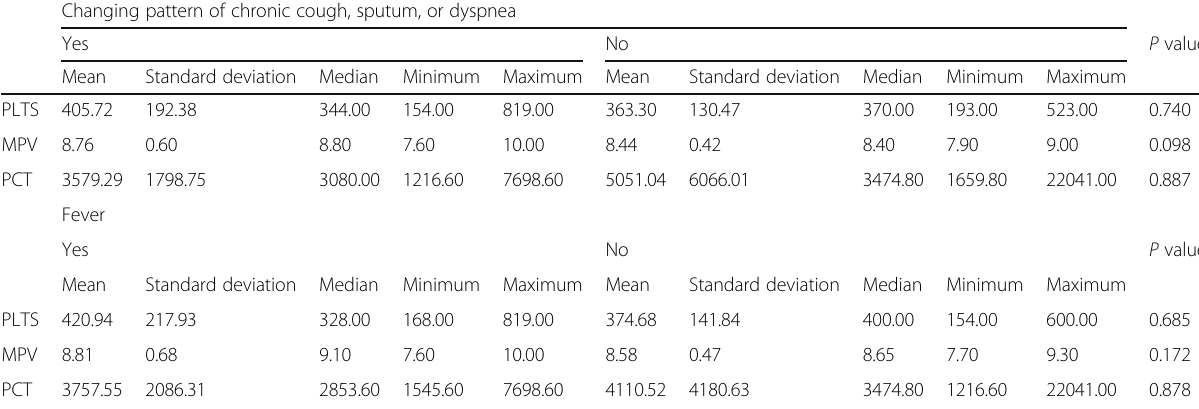
Table 4 Comparison between cases and controls; platelets count, MPV, and plateletcrit findings in relation to changing pattern of chronic cough and fever Changing pattern of chronic cough, sputum, or dyspnea Yes No Mean